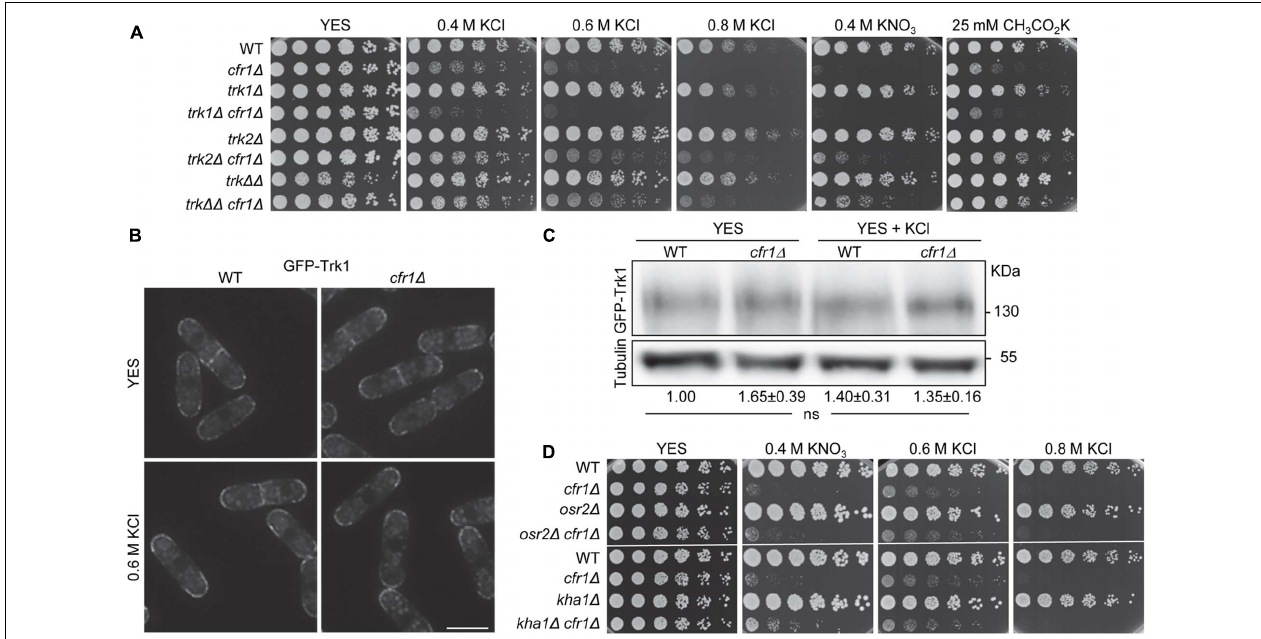
FIGURE 2 | Relationship between exomer and Trk transporters in the presence of potassium salts. (A) Cells from the indicated strains were spotted on YES (rich medium) and YES supplemented with the indicated concentrations of potassium salts. WT, wild-type; trk (cid:49)(cid:49) , trk1 (cid:49) trk2 (cid:49) . (B) DeltaVision images (SUM projections) of the WT and cfr1 (cid:49) cells bearing GFP-Trk1 and growing exponentially in YES and YES with 0.6 M KCl. Bar, 10 µ m. (C) Cell extracts from the indicated strains containing GFP-Trk1, and incubated in YES and YES with 0.6 M KCl, were subjected to SDS-PAGE and immunoblotted with anti-GFP (upper panel) and anti-tubulin (lower panel; loading control) antibodies. The relative position of molecular weight markers is indicated on the right (KDa). The intensity of each GFP-Trk1 band was relativized to the value for the corresponding tubulin band, and all the values were relativized to the value for the WT grown in YES. For each value, the mean of three independent experiments, standard deviation, and statistical significance of the difference, determined using the Tukey’s multiple comparisons test are shown (ns, non-significant). (D) Cells from the indicated strains were spotted on YES (rich medium) and YES supplemented with the indicated concentrations of potassium